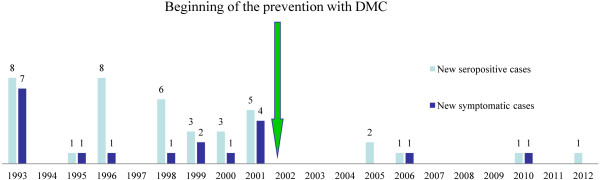
Incidence of leishmaniosis in a population of military dogs receiving a specific prevention (DMC) since 2002.